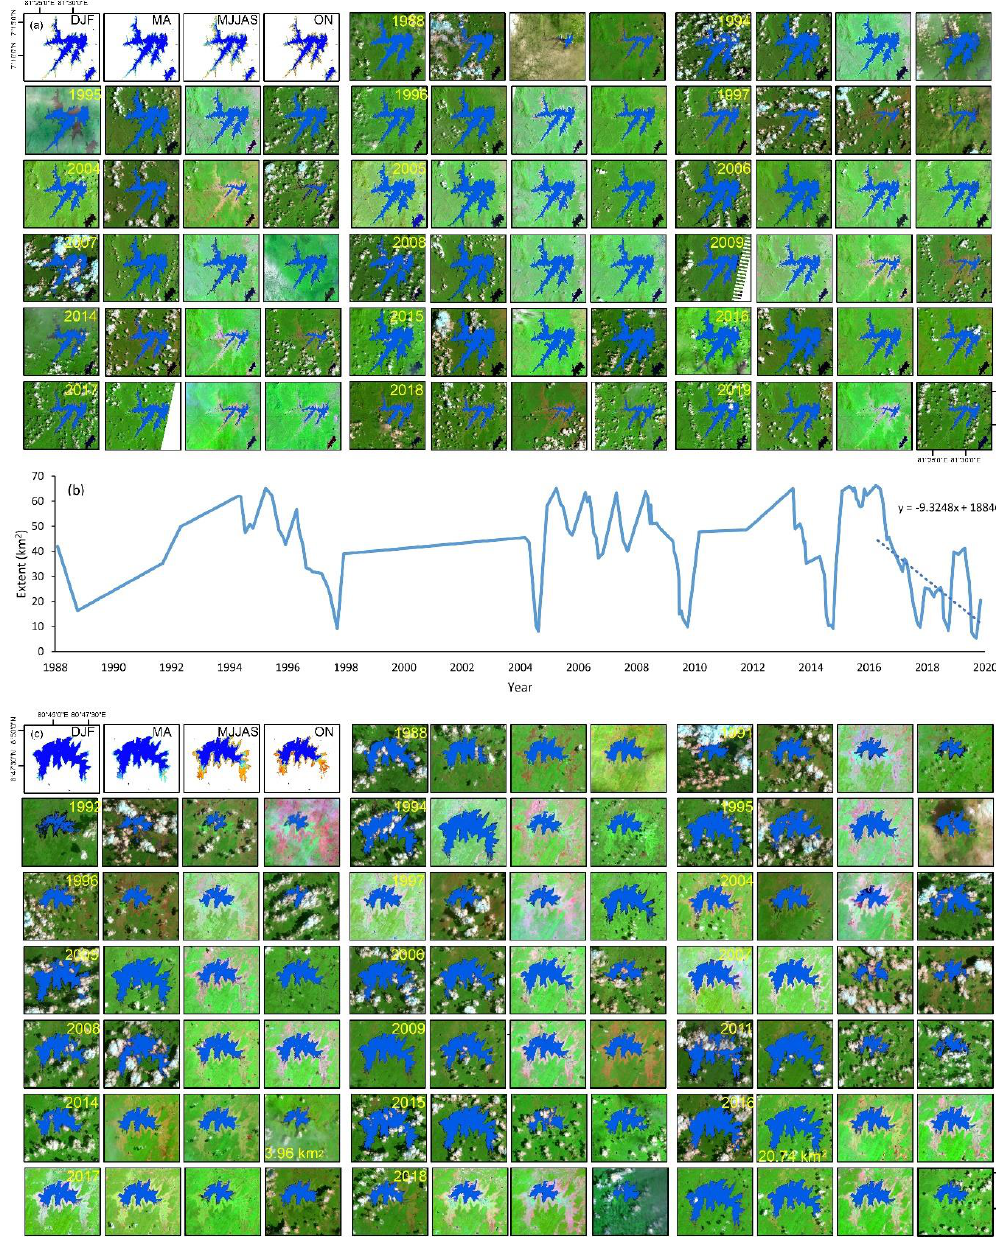
Figure 13. Variations in the spatial water extent of Senanayake Samudra and Padaviya reservoirs from 1988 to 2019. ( a ) Seasonal water extent of Senanayake Samudra as mapped by our LVQ model, displayed over Landsat 5 TM imagery (bands 7, 4, 2 as RGB) and Landsat 8 OLI imagery (bands 7, 5, 3 as RGB). ( b ) Variations in the area of Senanayake Samudra reservoir with all available good-quality observations. ( c ) Seasonal water extent of Padaviya as mapped by our LVQ model, displayed over Landsat 5 TM imagery (bands 7, 4, 2 as RGB) and Landsat 8 OLI imagery (bands 7, 5, 3 as RGB).